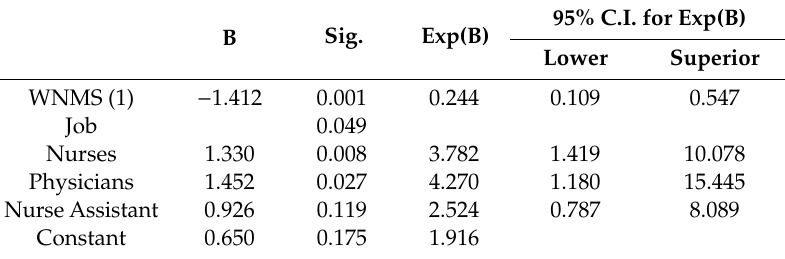
Table 3. Results of logistic